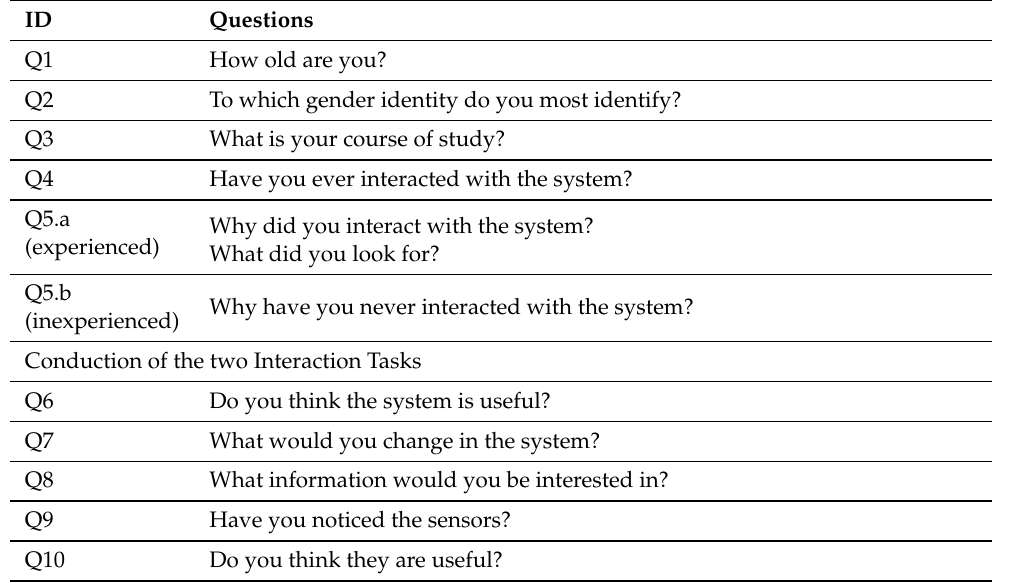
Table 1. Questions asked during the